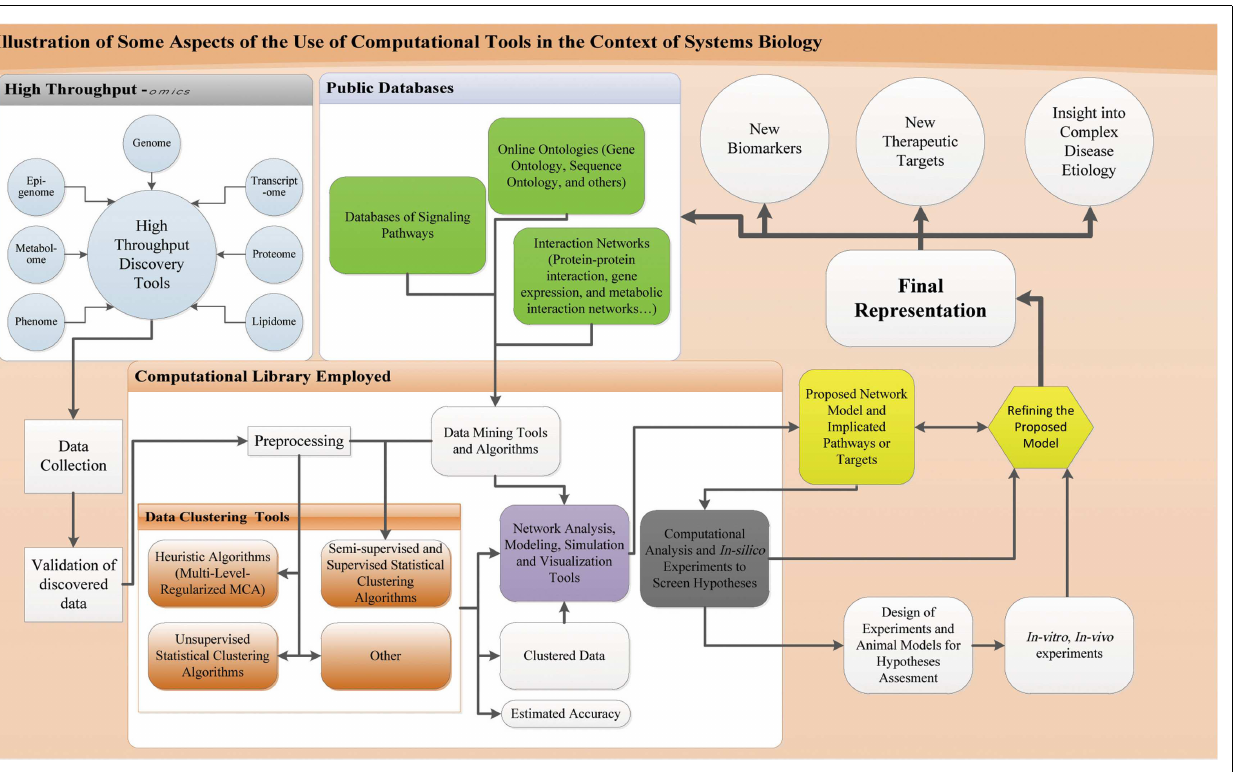
public databases fed through data mining techniques and also utilize the previous mentioned algorithms.The output of such tools is a model of the implicated network.This model is subject to computational analysis and in silico modeling and simulations for hypotheses screening using computer models.These simulations and models allow refining the proposed network and orient the design of appropriate in vitro and in vivo experiments on a fit animal model or concerned human cells.These in vivo and in vitro experiments are run to assess the hypotheses and predictions of the modeled network and allow for support or refinement of the network. After enough evidence is collected through these rounds of experimentation and hypotheses testing, a final representation of the system is devised that could account to a disease pathogenesis or normal physiology.This representation allows for biomarker and new therapeutic discovery, provides an insight into the pathophysiology or normal physiology and can help update the online